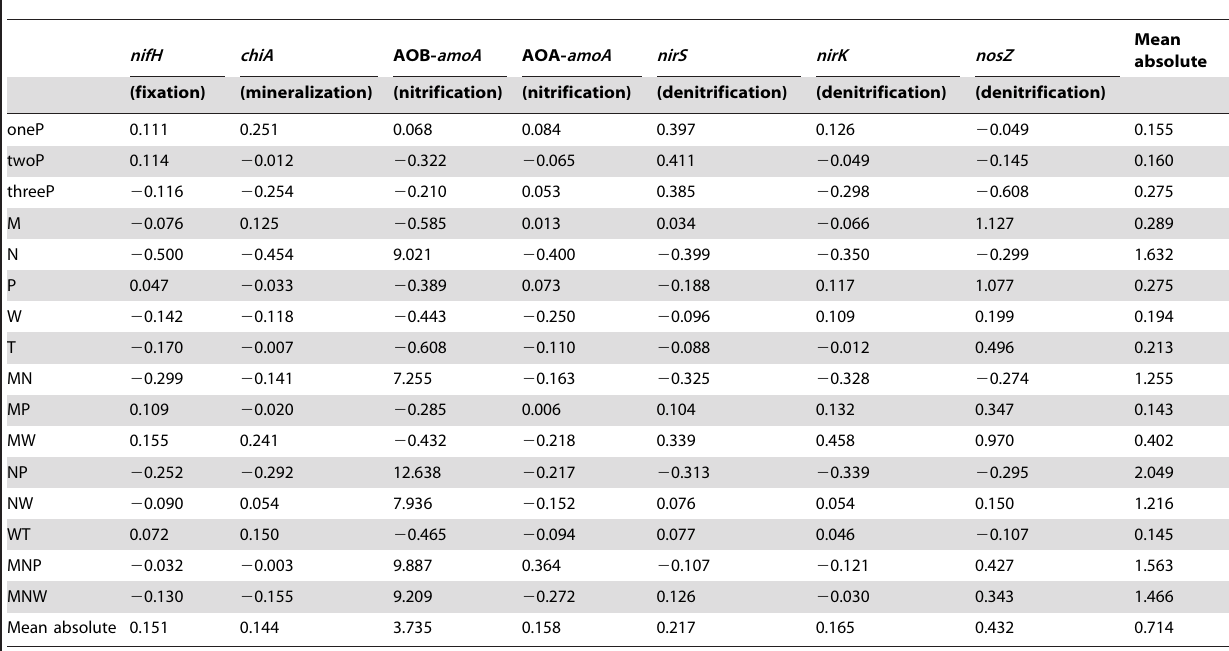
Table 1. Relative changes in the abundance of various N-cycling genes caused by different treatments.